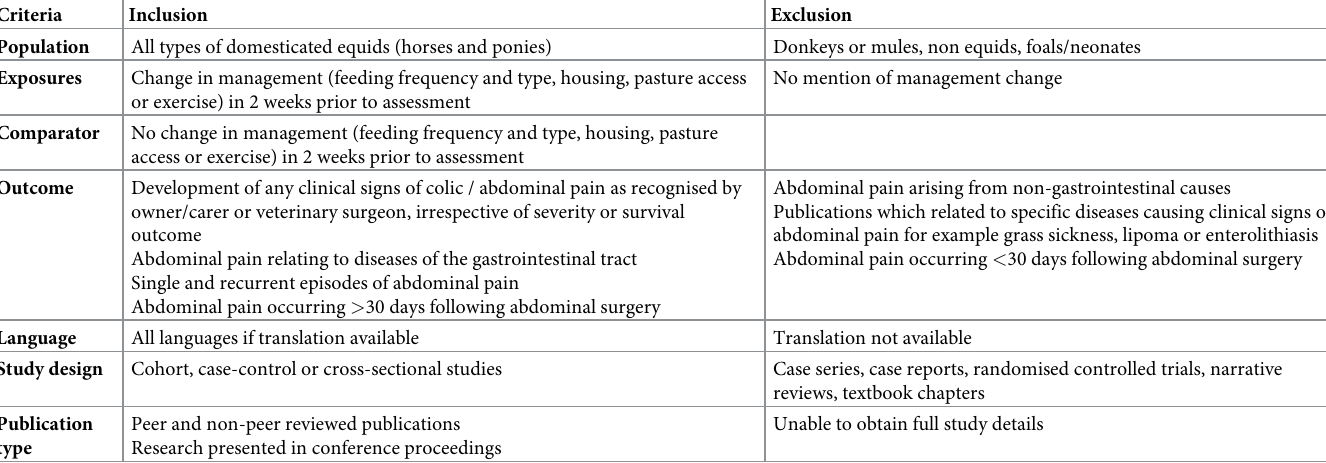
Table 2. Inclusion and exclusion criteria for a systematic review of management-related factors associated with the risk of developing abdominal pain (colic) in adult